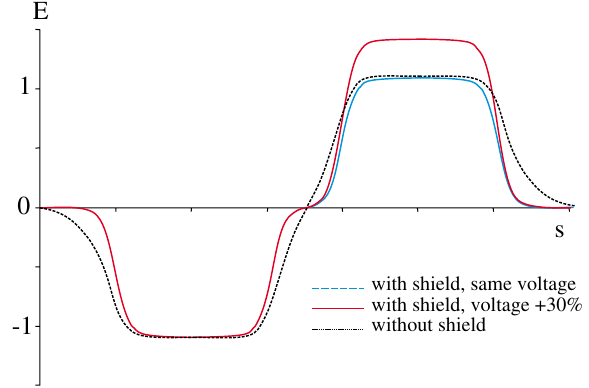
FIG. 10. (Color) Comparison of the potential distribution in- side the electrostatic quadrupole doublet with and without grounded shields between the lenses; arbitrary units.